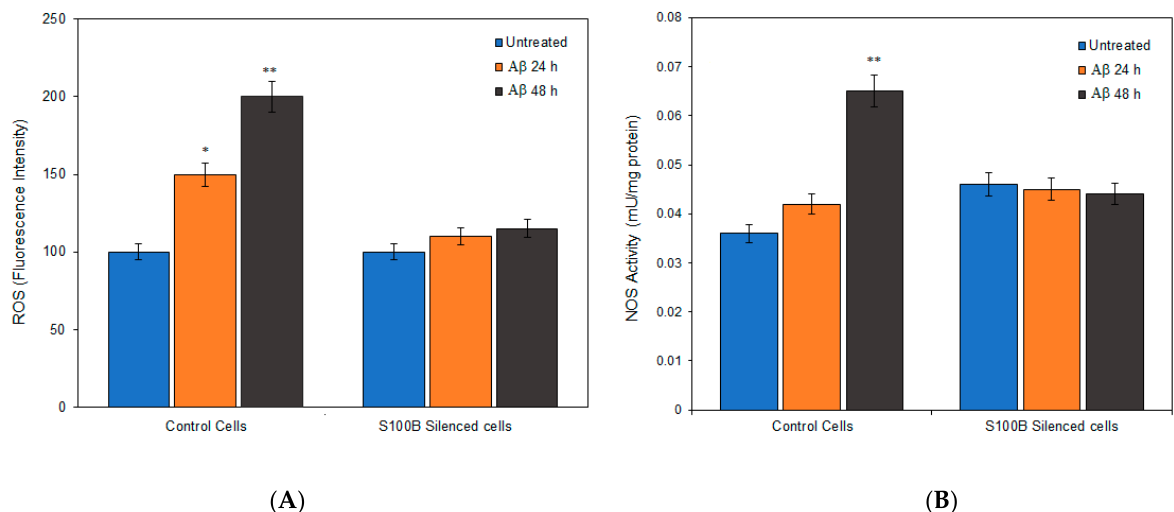
Figure 4. ( A ) ROS expressed as intensity fluorescence (percentage relative to the untreated cells) and ( B ) NOS activity (displayed as milliunits/milligrams of protein) for untreated cells (blue bars), treated with 10 µ M A β for 24 h (orange bars) and 48 h (black bars). * p < 0.05 and ** p < 0.001 vs.